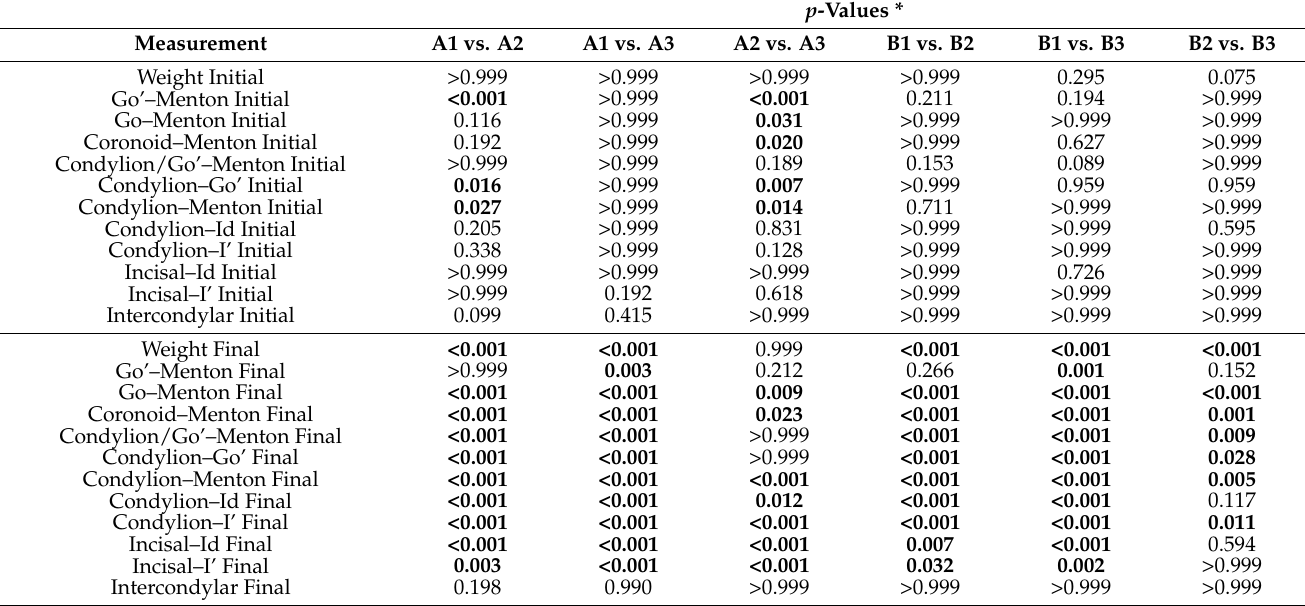
Table 5. Pairwise timing per group measurement comparisons’ p -values derived from linear regres- sion models, adjusted for multiple comparison (Bonferroni). p -Values